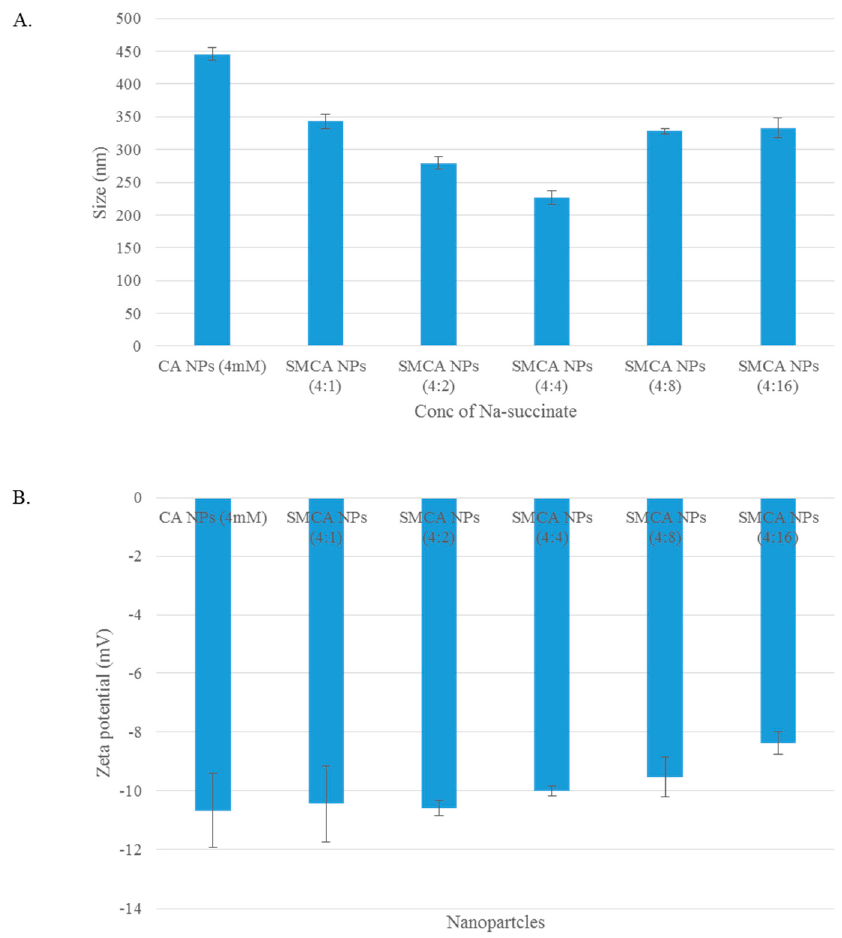
Figure 2. ( A ) Size of SMCA NPs; ( B ) zeta potential of SMCA NPs.